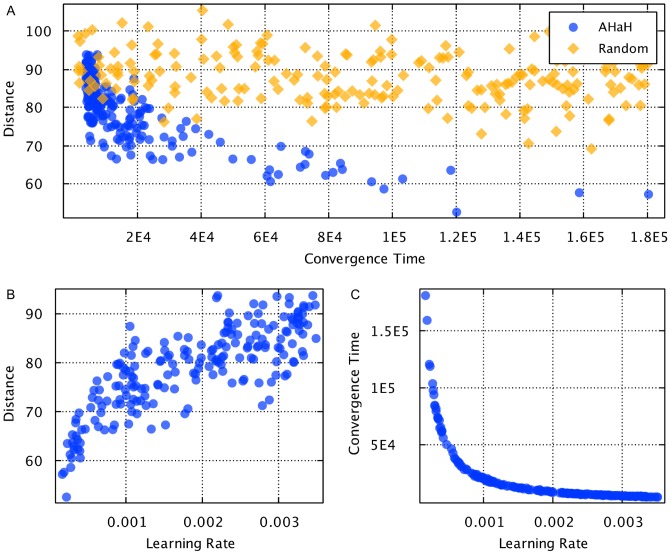
64-city traveling salesman experiment.By using single-input AHaH nodes as nodes in a routing tree to perform a strike search, combinatorial optimization problems such as the traveling salesman problem can be solved. Adjusting the learning rate can control the speed and quality of the solution. A) The distance between the 64 cities versus the convergences time for the AHaH-based and random-based strike search. B) Lower learning rates lead to better solutions. C) Higher learning rates decrease convergence time.